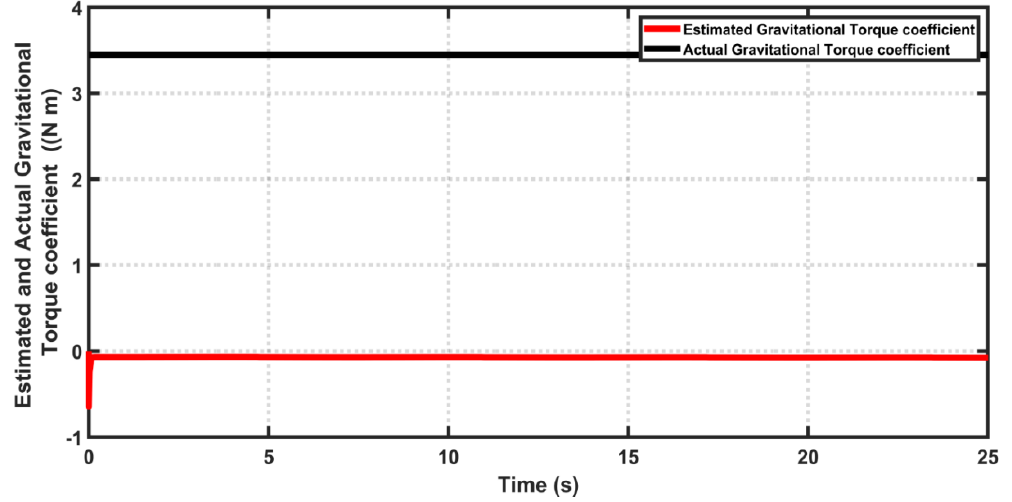
. Figure 14. Behaviors of actual and estimated gravitational torque coefficients τ . g . 𝜏𝜏 𝑔𝑔 𝜏𝜏 𝑔𝑔 𝜏𝜏 𝑔𝑔